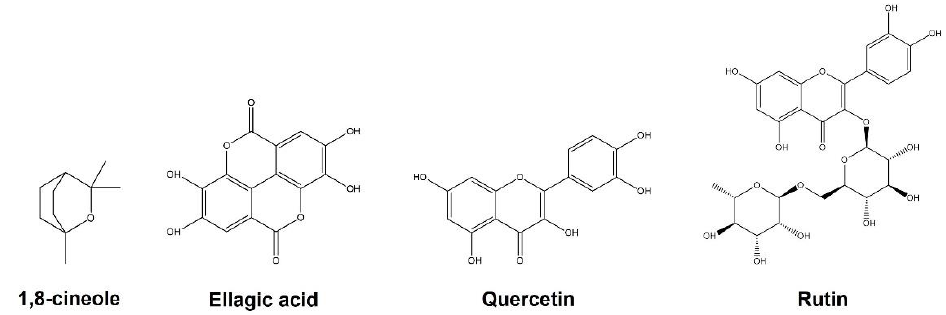
Figure 1. Major compounds found in essential oils and phenolic extracts obtained from E. globulus leaves.